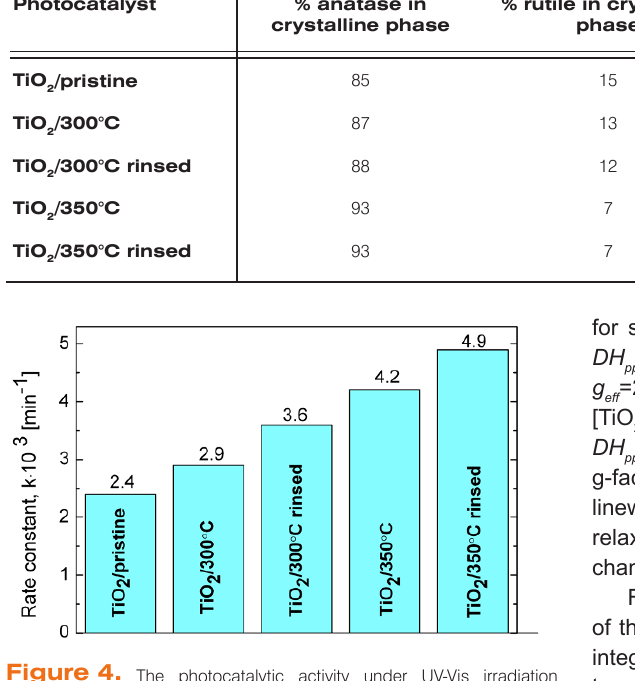
Figure 4. The photocatalytic activity under UV-Vis irradiation expressed as constant rate of phenol decomposition for all investigated samples.